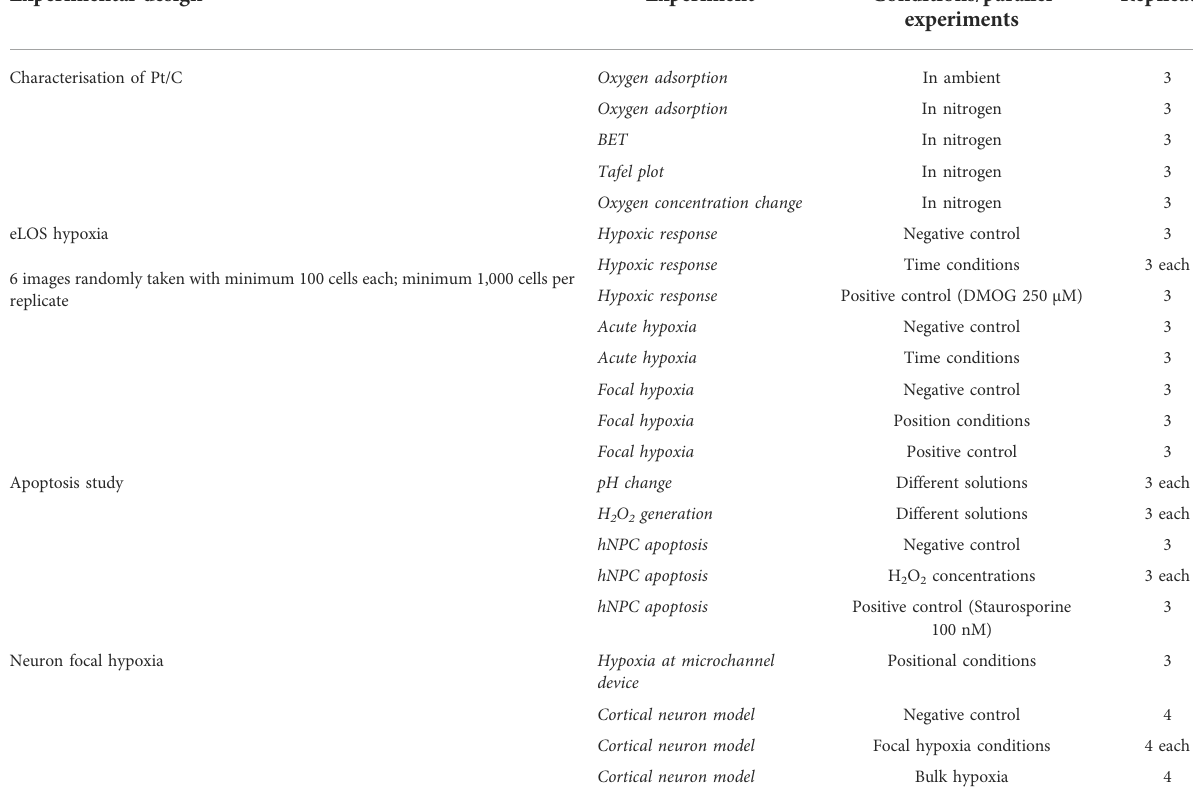
TABLE 2 Experimental